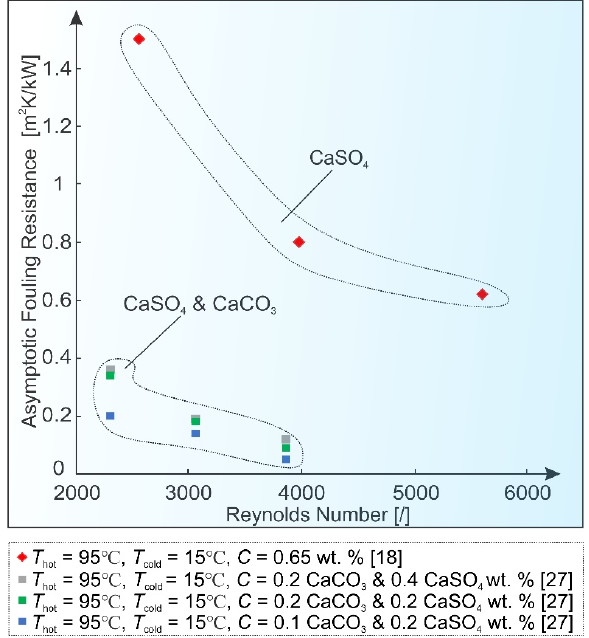
Figure 6. Reynolds number effect on asymptotic fouling resistance values.